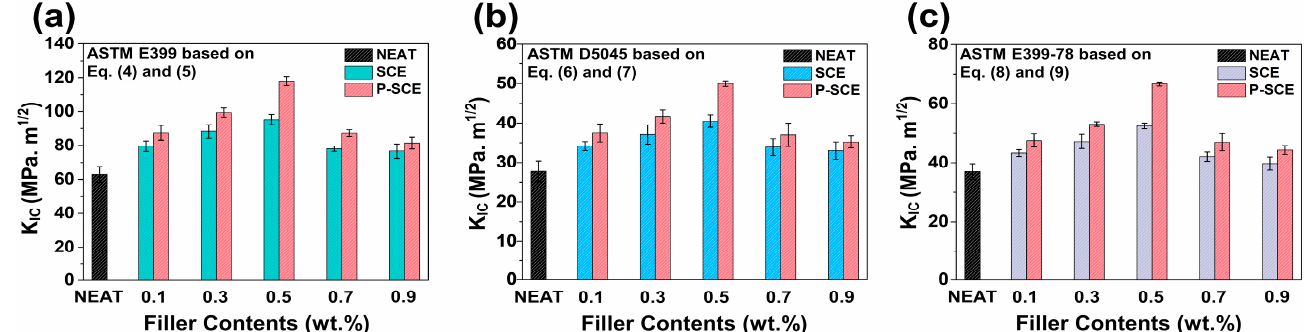
Figure 5. K IC comparison values of SCE and P-SCE composites according to the formula: ( a ) ASTM E399, ( b ) ASTM D5045, and ( c ) ASTM E399-78. Table 1. Comparison of K IC improvement values by nano-fillers type in the reported literature. Nano-Fillers Filler Content (wt.%)